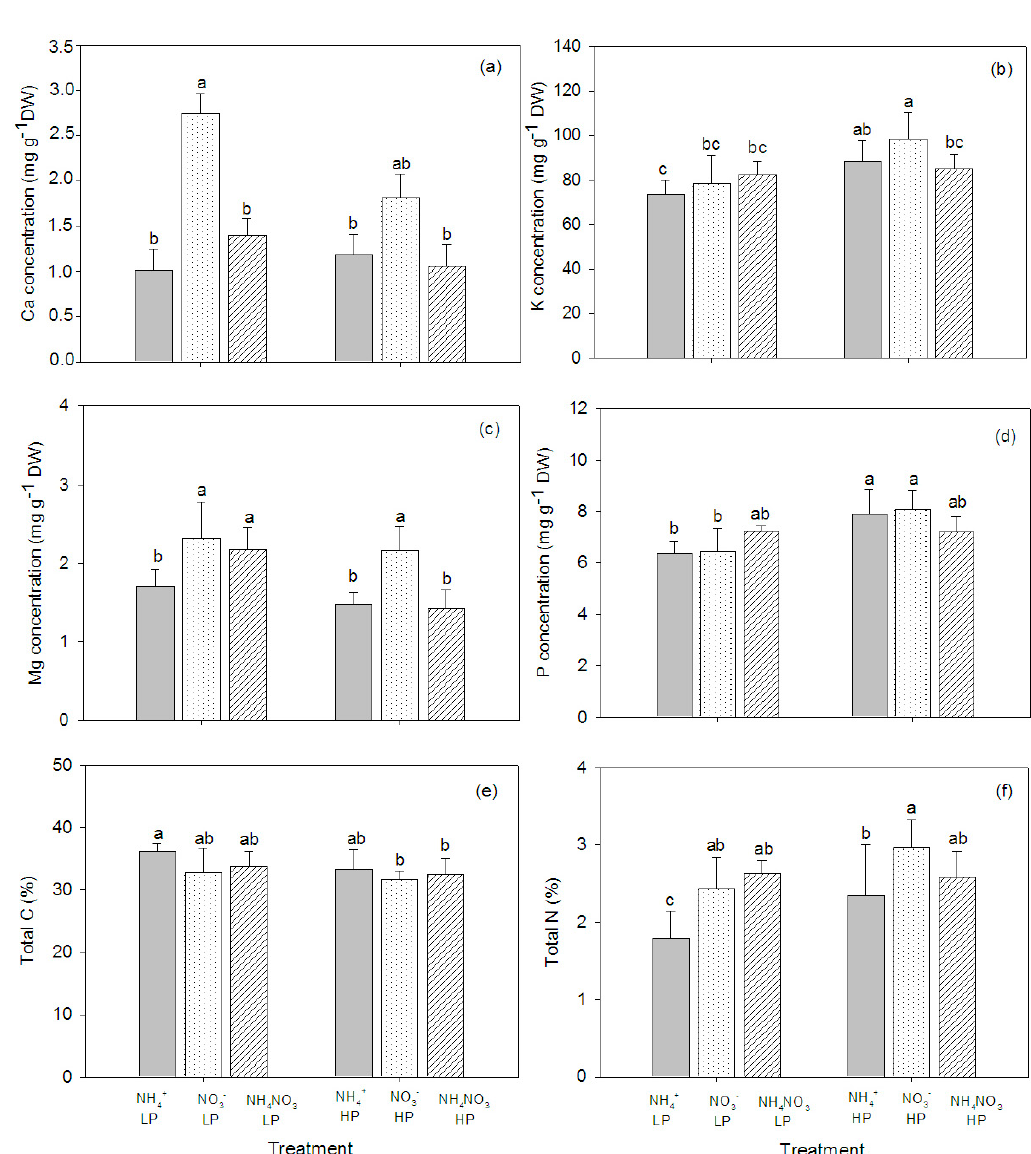
Figure 4. Concentrations of Ca ( a ), K ( b ), Mg ( c ), P ( d ), total C ( e ), and total N ( f ) in stems of hybrid Napier grass ( Pennisetum purpureum × P. americanum ) (mean ± SD) grown on different N forms (NH 4+ , NO 3 − , and NH 4 NO 3 ) and P concentrations (LP, low P concentration (100 µM P); HP, high P concentration (500 µM P)). Different letters above columns indicate significant differences between treatments.